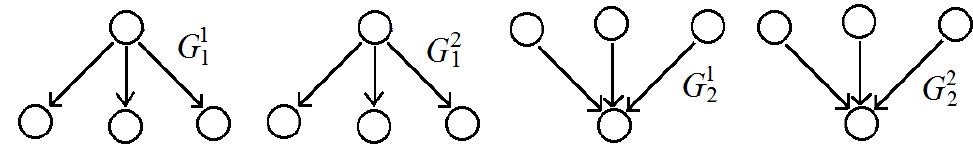
Figure 1. Unrelated stars G 1 Theorem 1. Equality | p ( (cid:98) G ) | = max ( | V 1 | , | V 2 | ) is